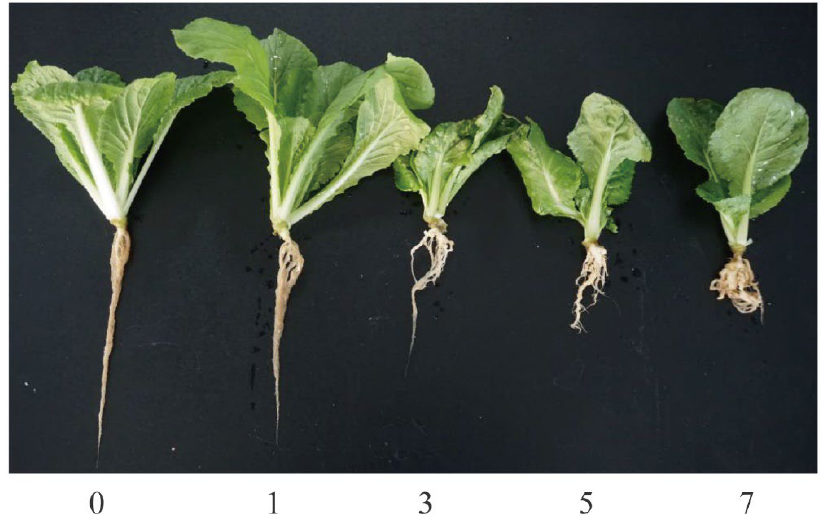
Figure 1. Disease symptoms are appeared both in roots and leaves of Chinese cabbage after 30 days of inoculation. The scales are defined as 0: had no tumor; 1: there was a small tumor in the lateral root; 3: taproot enlargement with a diameter less than 2 times of stem base; 5: taproot enlargement with a diameter 3 to 4 times of stem; 7: taproot enlargement, more than 4 times diameter of base of stem or blackening of the swollen root. Table 1. Number of individual plants were identified as clubroot resistance and susceptible from F 2 population were screened in the spring and autumn seasons in the field trials after artificial inoc- ulation with clubroot spores (10 7 spores/mL).